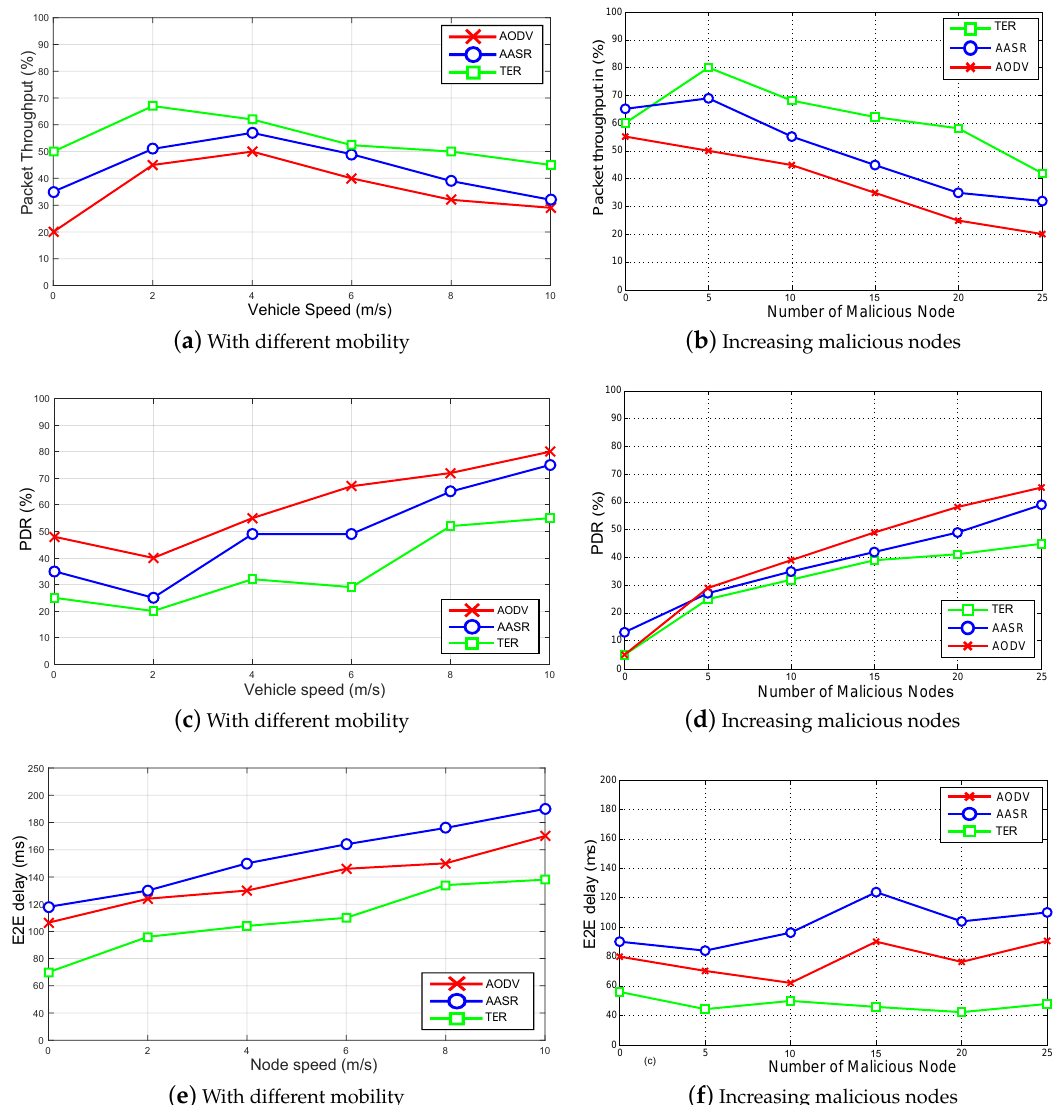
Figure 6. Packet throughput, PDR, and E2E delay with different vehicles mobility and increasing malicious